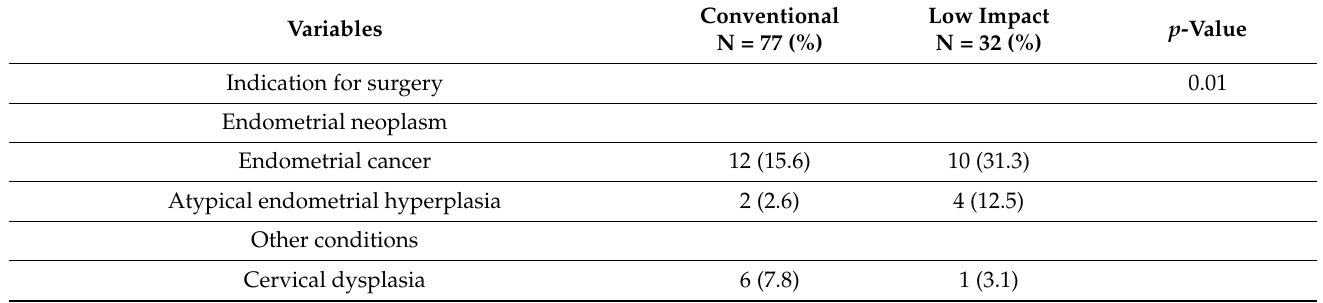
Table 2. Surgical